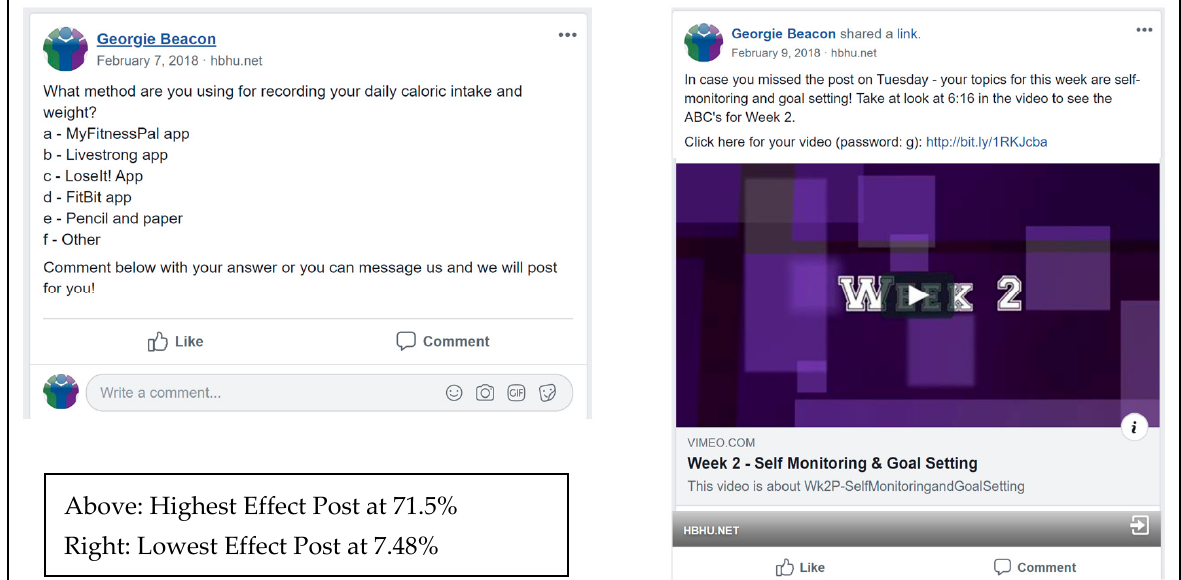
Figure 5. Highest vs. Lowest Effect Post as they appeared on Facebook. Note: For coding data, see Wk2_Wednesday for Highest and Wk2_Friday for lowest in Table 2.